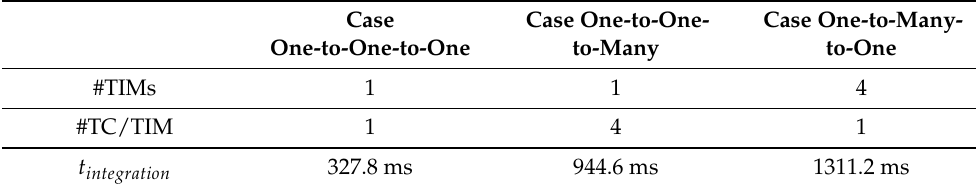
Table 2. Estimation of Integration Time for Different Scenarios.